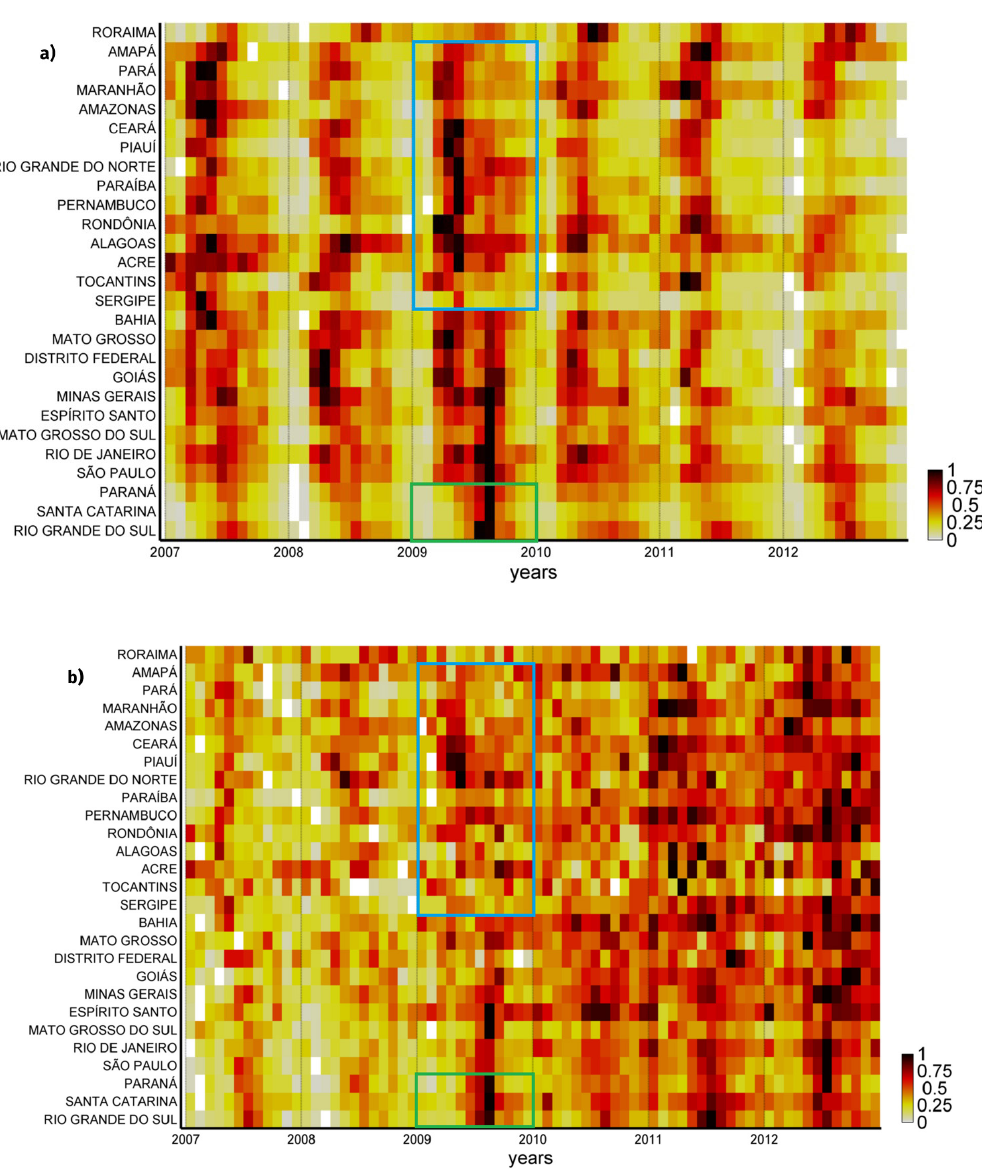
Figure 1. Heat-grids of monthly ( a ) hospitalization and ( b ) mortality in each state of Brazil as an ordinate from North (upper) to South (lower). Data are standardized to proportions with maximum of one per time